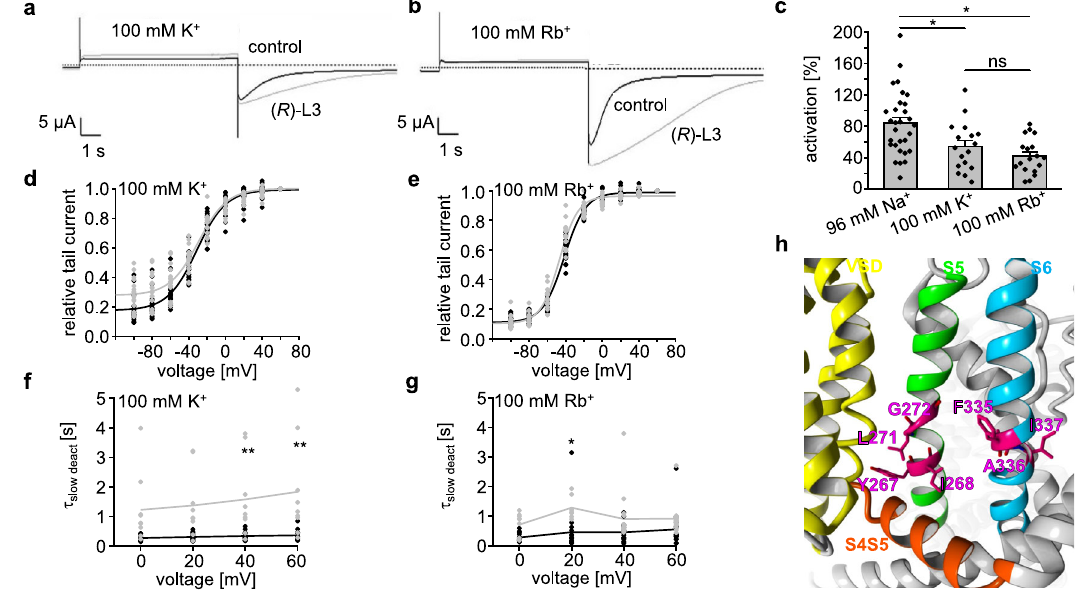
Fig. 2 Effect of ( R )-L3 on hK v 7.1 in high K + and Rb + buffer. a , b Representative current traces in 100 mM K + ( a ) and 100 mM Rb + ( b ) before (black; ctrl) and after (gray; + ( R )-L3) addition of 1 µ M ( R )-L3. c Activation of hK v 7.1 channel currents by 1 µ M ( R )-L3 expressed as percent change in current in high K + and Rb + ( n = 18 for K + , n = 17 for Rb + ) compared to activation measured in ND96 ( n = 30). Signi fi cance of mean differences was evaluated by one-way ANOVA and posthoc mean comparison Tukey test (ns for p > 0.05, * p < 0.05). d , e Current-voltage relationship for hK v 7.1 expressing oocytes in the absence (black, n = 18 for K + and Rb + ) and presence (gray, n = 17 for K + , n = 18 for Rb + ) of 1 µ M ( R )-L3 in 100 mM K + ( d ) and 100 mM Rb + ( e ). V 1/2 values were determined from normalized peak tail currents at − 120 mV for each oocyte and fi tted to Boltzmann equation. f , g Slow deactivation component of hK v 7.1 in high K + ( f ) and high Rb + ( g ) in the absence (black; n = 15 for K + , n = 18 for Rb + ) and the presence (gray; n = 9 for K + and n = 18 for Rb + ) of ( R )-L3. Time constants τ slow deact were determined by two-component exponential fi t for each oocyte and voltage step. h Depiction of KCNQ1 in activated state (AO, derived from Kuenze et al 38 . Amino acids crucial for ( R )-L3 activity (magenta) are located at the lower S5 (green) and S6 (blue) helix. Most side chains of the crucial amino acids are orientated to the S4S5 Linker (orange) and VSD (yellow) of an adjacent KCNQ1 subunit.